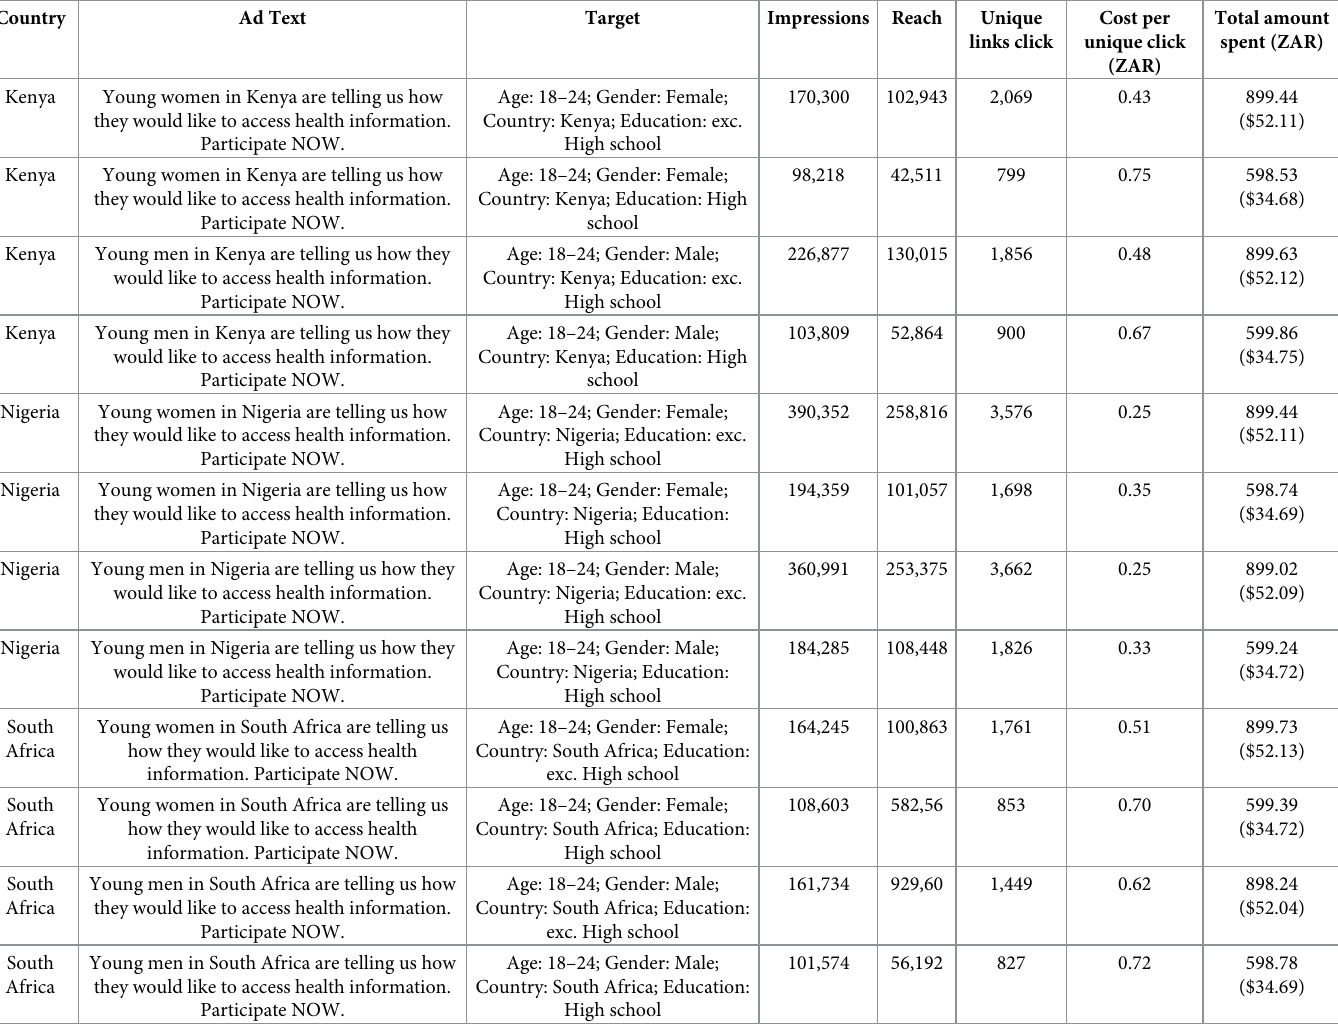
Table 3. Summary of Ad.